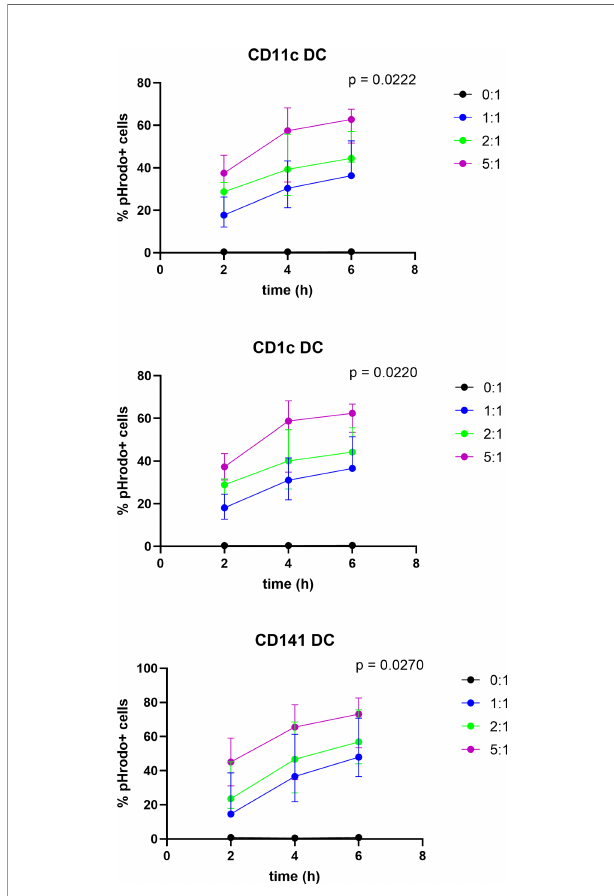
FIGURE 4 | Uptake of T-VEC-treated dying melanoma cells by BDCA-1 + / BDCA-3 + myDC. 938-mel cells were treated with T-VEC at a MOI of 1 for 24h. Then, cells were harvested, counted and labeled with the pHrodo ™ Deep Red Mammalian and Bacterial Cell Labeling Kit. After labeling, labeled T-VEC-treated dying 938-mel cells were put in co-culture with puri fi ed BDCA- 1 + /BDCA-3 + myDC at the indicated ratios for 2, 4 or 6h. After co-culture for the indicated time points, cells were harvested and analyzed by fl ow cytometry. The different DC populations were gated and the percentage of pHrodo ™ -positive cells was determined. Each panel shows the uptake by the indicated DC population. Data are represented as mean ± SD from 3 independent